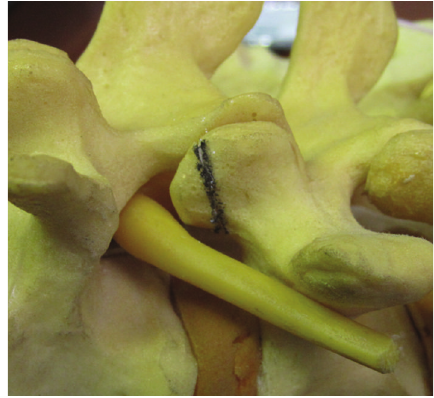
Figure 3: Dental instrument inserted to palpate the pedicle before osteotomy.